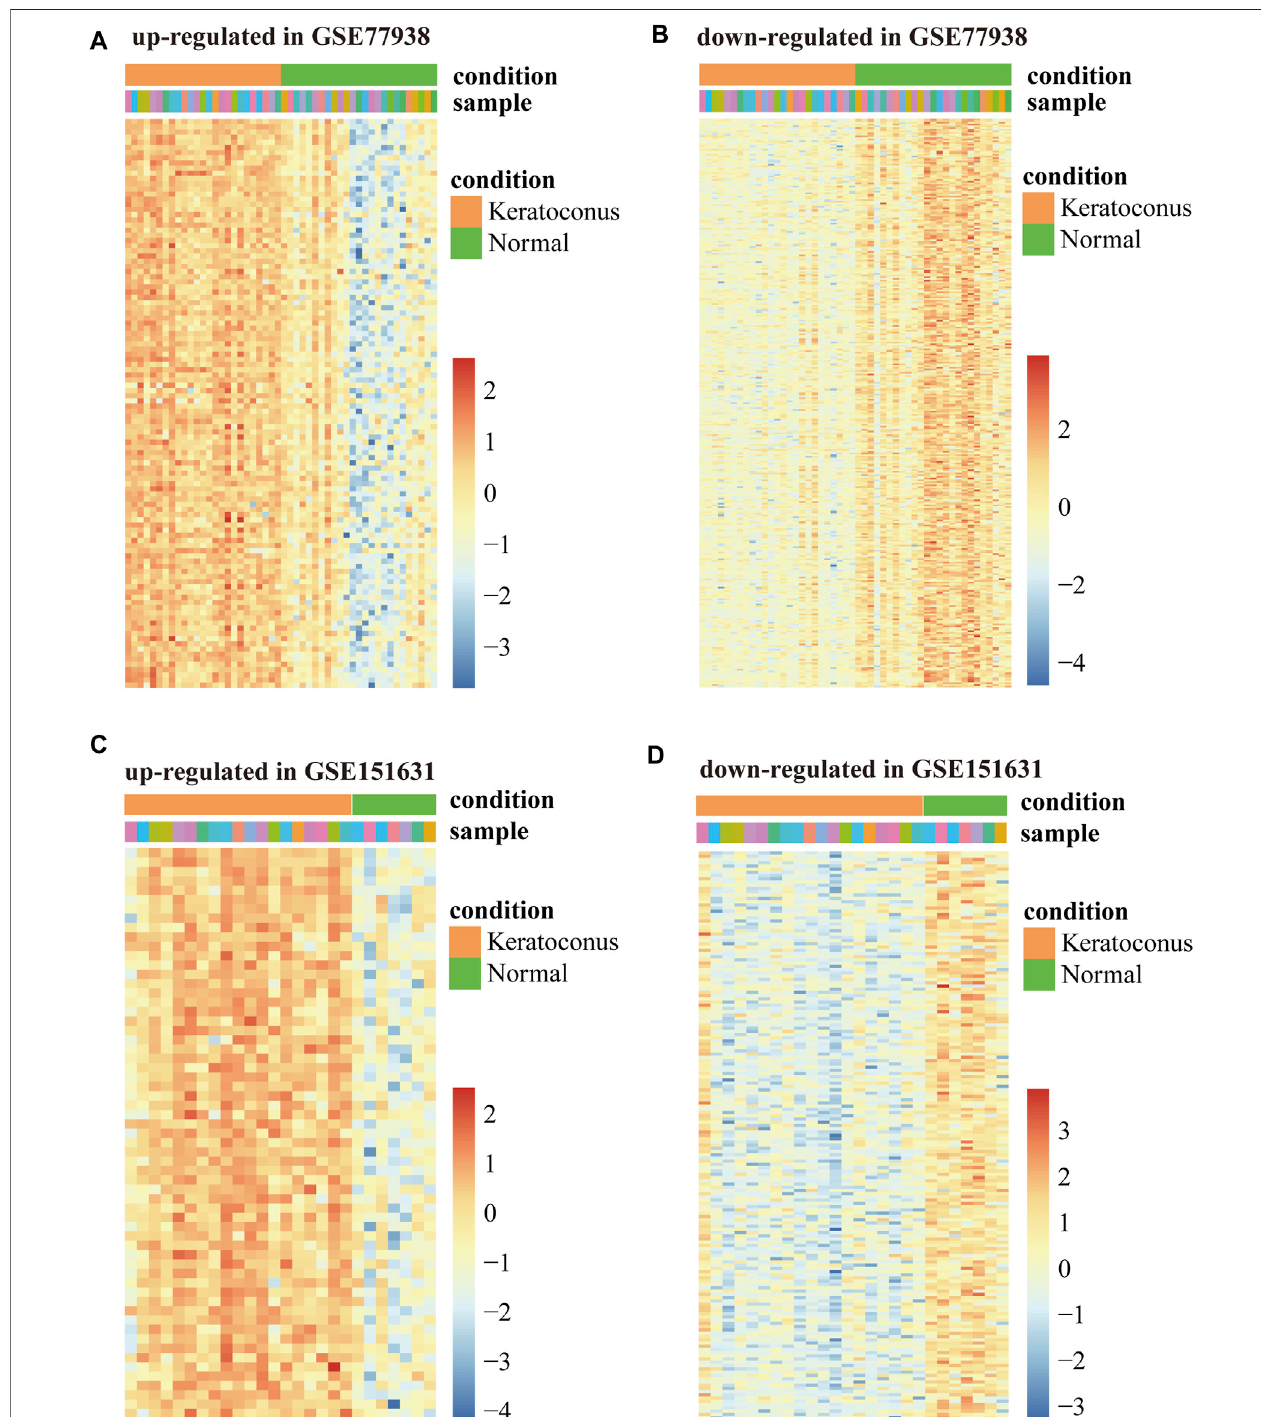
FIGURE 2 | Heatmap of DEGs in GSE77938 and GSE151631. (A) Heatmap showing upregulated intersected DEGs in GSE77938. (B) Heatmap showing downregulatedintersectedDEGsinGSE77938. (C) HeatmapshowingupregulatedintersectedDEGsinGSE151631. (D) Heatmapshowingdownregulatedintersected DEGs in